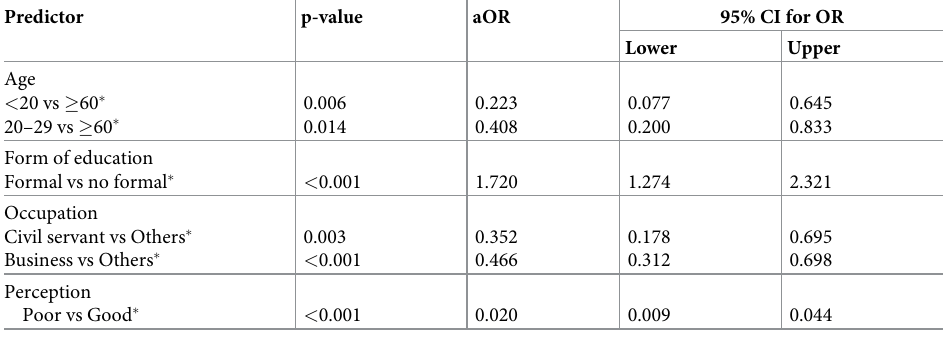
Table 6. Logistic regression analysis for predictors of willingness to take COVID 19